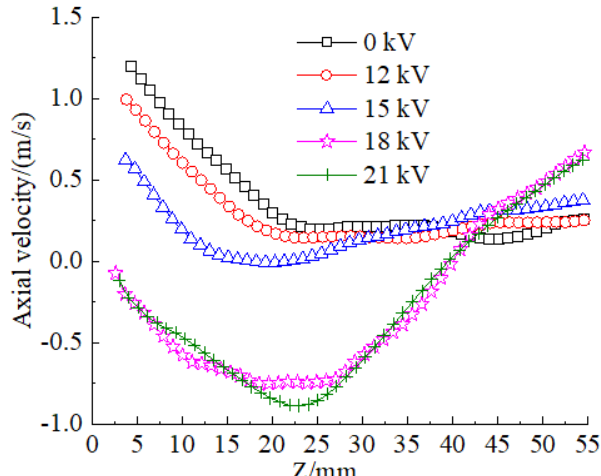
Figure 4. Profiles of the mean axial velocity.